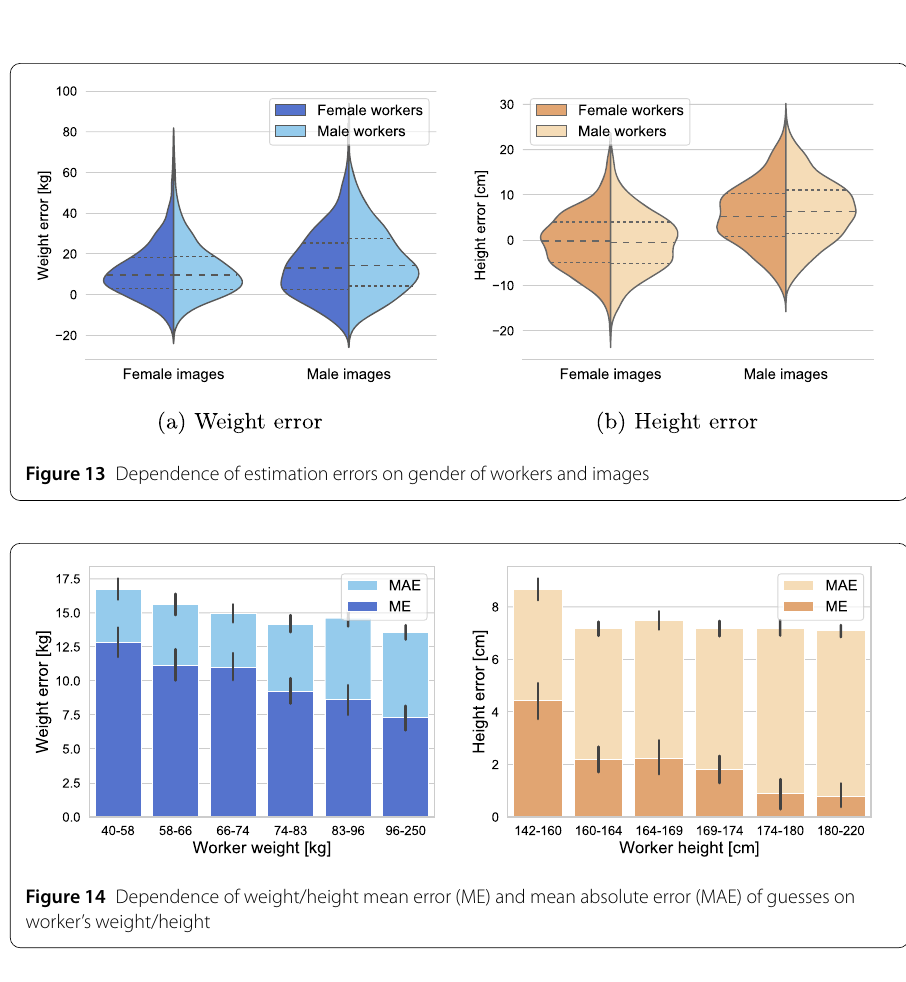
weight of male images in the dataset (standard deviation 25.6 kg for men, vs. 21.7 kg for